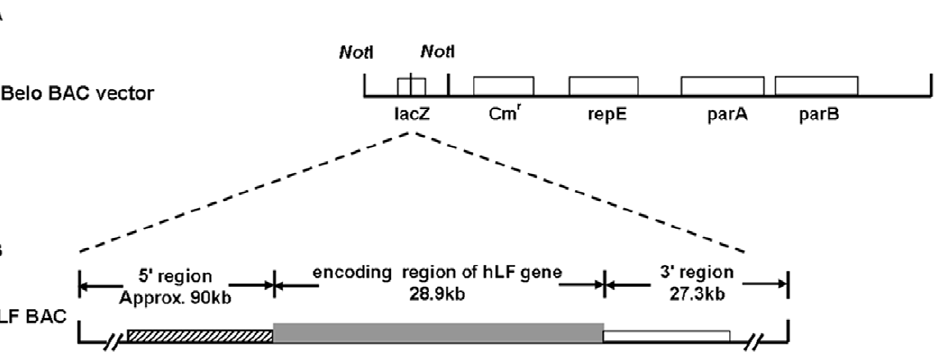
Figure 1. Schematic representation of the transgene constructs. (A) Structure of the transgene construct released from the pBeloBAC vector by Not I digestion. The transgene backbone contains the lacZ gene, the chloramphenicol resistance gene (Cm r ) and the regulatory genes repE, parA and parB. The dotted lines indicate the insertion position of the hLF BAC into the pBeloBAC vector. (B) The hatched, gray and open boxes represent the 5 9 regulatory, encoding and 3 9 regulatory regions, respectively, of the hLF gene.